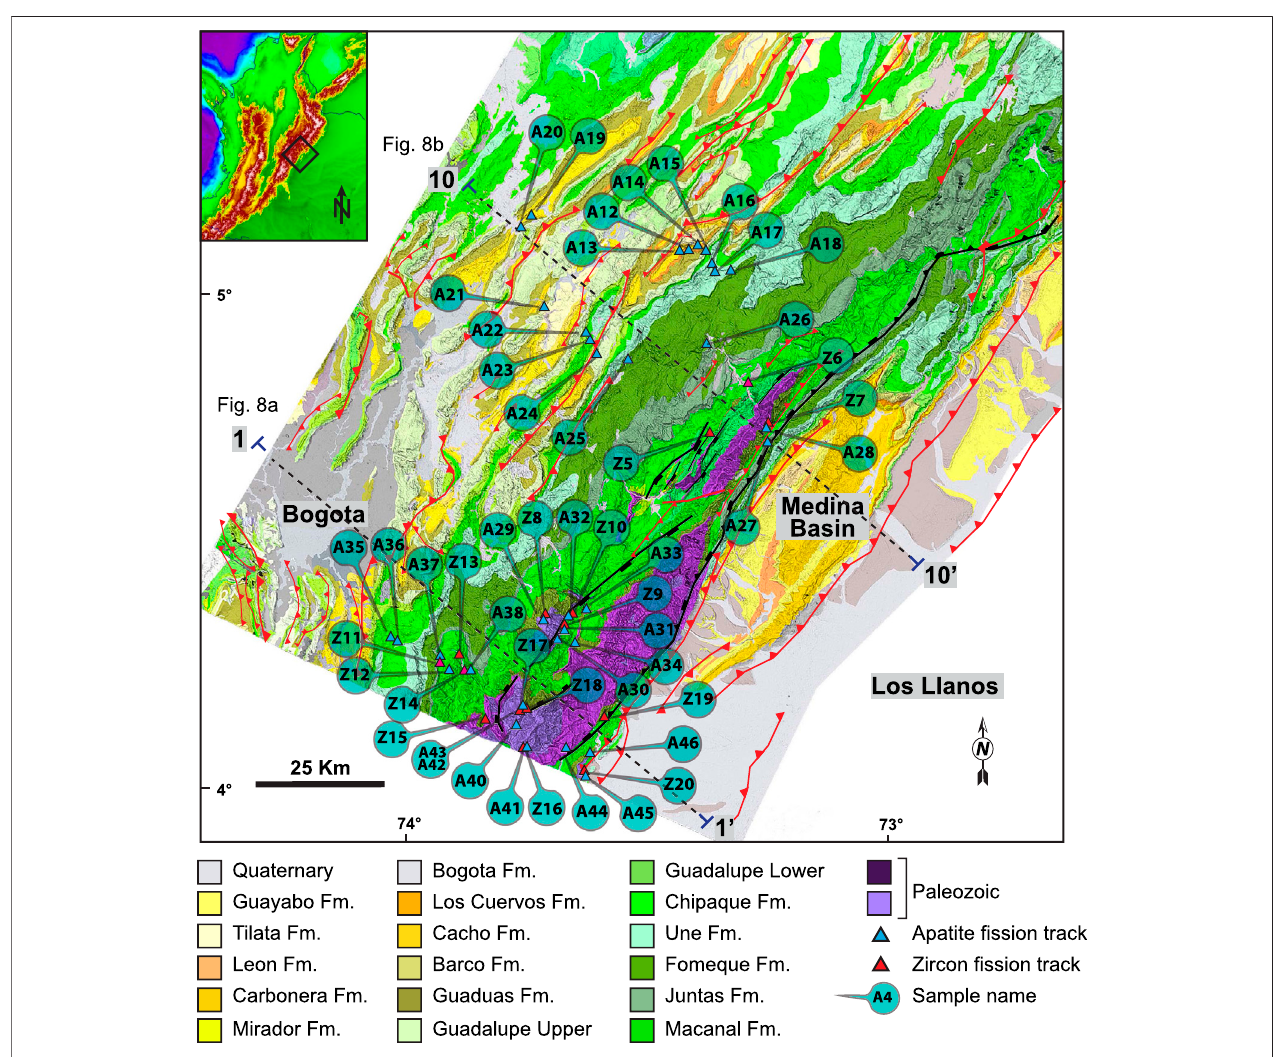
FIGURE 5 | Geological map with the apatite and zircon fi ssion track sample distribution, and the trace of the two cross-sections restored in this study.